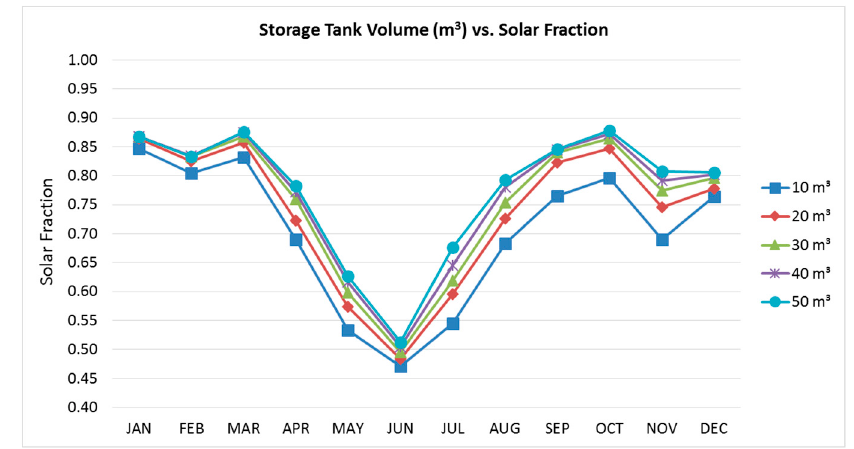
Figure 6. The impact of storage tank volume on solar fraction.